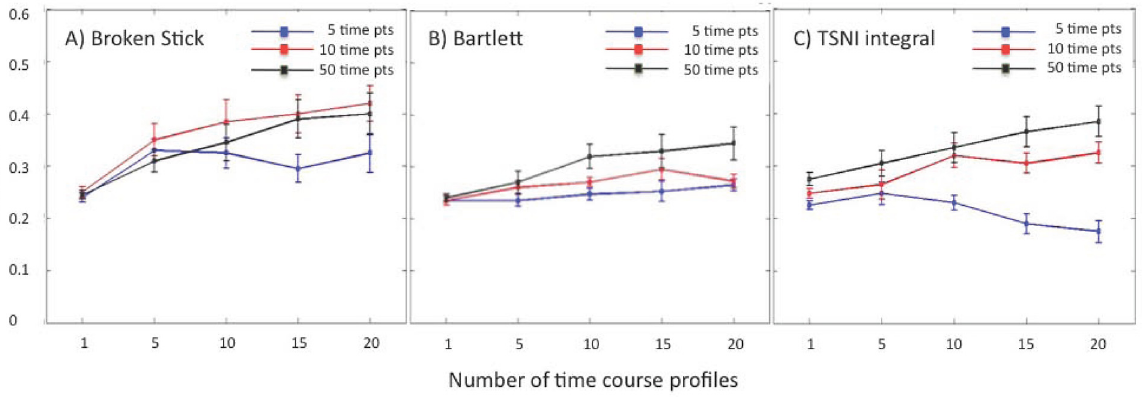
Fig 3. Median F scores calculated on 10 different simulated 10-node networks recovered using (A) Broken stick (B) Bartlett ’ s and (C) TSNI integral methods on group of expression profiles . Each network was used to generate groups of 1, 5, 10, 15 and 20 simulated time courses each sampled at 5 (blue), 10 (red) and 50 (black) time points. All simulations included 20% experimental